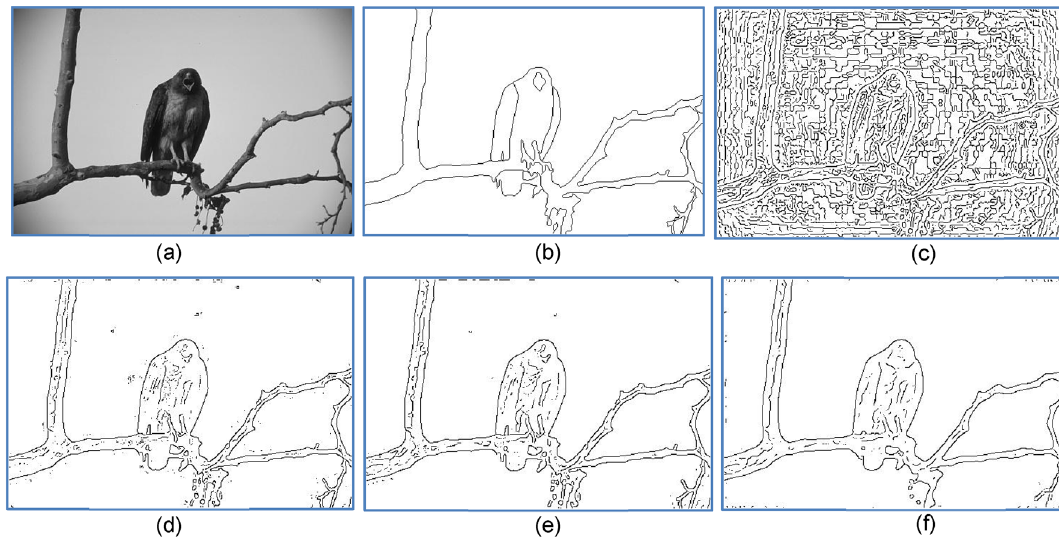
Figure 12. ( a ) Input image corrupted by Gaussian noise. ( b ) GT. ( c ) CEP generated by Canny detector ( H t = 0.01 ) , used as candidate pixels for ( d – f ), ( d ) Without prefilter, (MQ, EQ, FoM, sR) = (0.92, 0.85, 0.81,